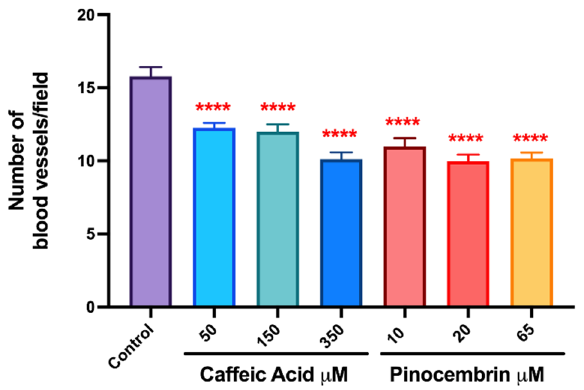
Figure 4. Antiangiogenic effect of treatment with caffeic acid and pinocembrin on the formation of vessels in the chorioallantoic membrane of embryonated chicken eggs. Three sections per egg were analyzed, blood vessels were photographed and counted per mm 2 of optical field. The numerical data show the mean ± standard deviation of the results obtained in independent experiments. Statistically significant differences are indicated compared to controls (**** = p < 0.0001; n = 3).